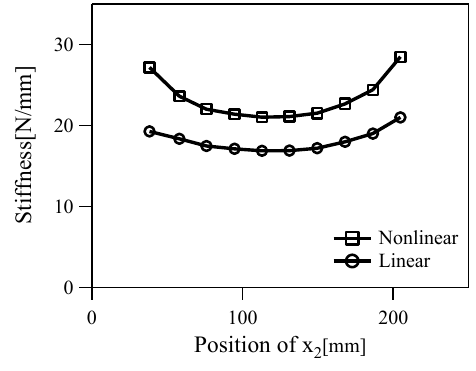
Figure 13. Relationships between stiffness and position of x (cid:2870) of the string